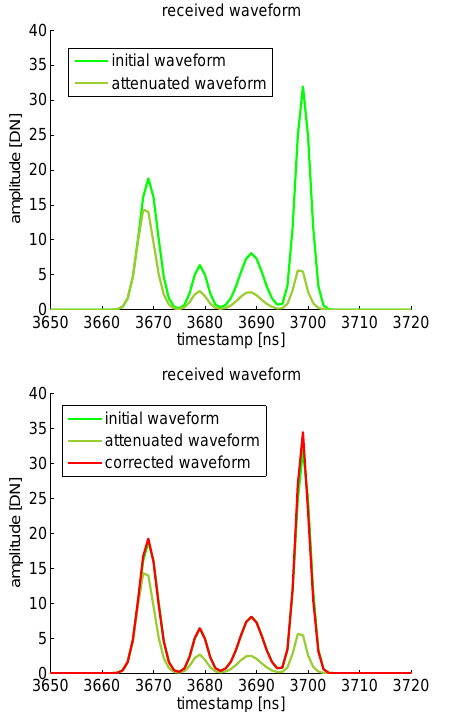
Figure 6: Initial and attenuated waveform (top), received wave- form after applying the integral correction method (bottom)